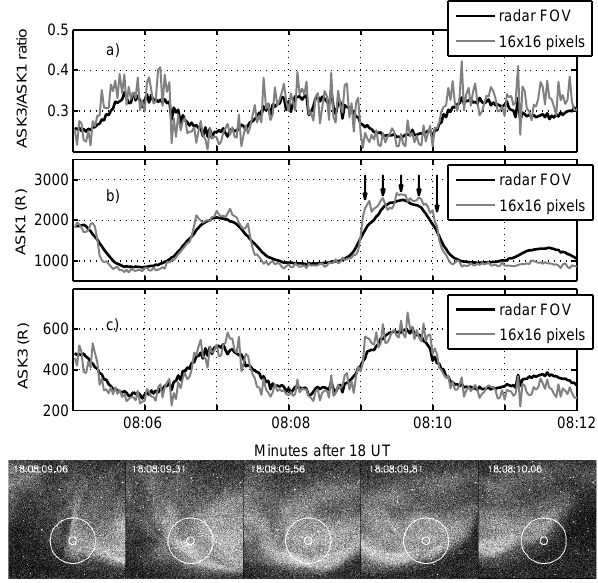
Fig. 10. (a) Measured OI/N 2 ratio (b) brightness of ASK1 and (c) ASK3, from 18:08:05UT to 18:08:14UT, at two spatial reso- lutions: the field of view of radar (black) and 16 × 16 pixels in the magnetic zenith (grey). (bottom) Images 250ms apart starting at 18:08:09UT as marked in